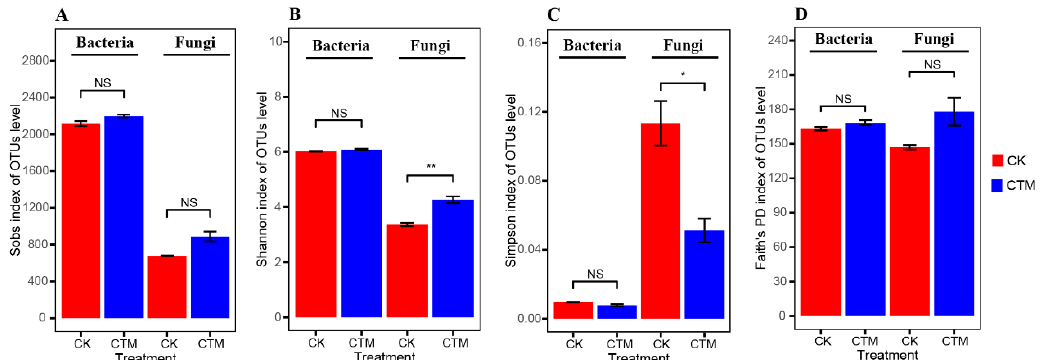
Figure 1. α diversity of soil bacterial and fungal communities in an L. gmelinii plantation after crop tree management. CTM, crop tree management. ( A ) observed number of OTUs (Sobs); ( B ) Shannon index; ( C ) Simpson index; ( D ) Faith’s PD index. NS, not significant; * p < 0.05; ** p < 0.01.